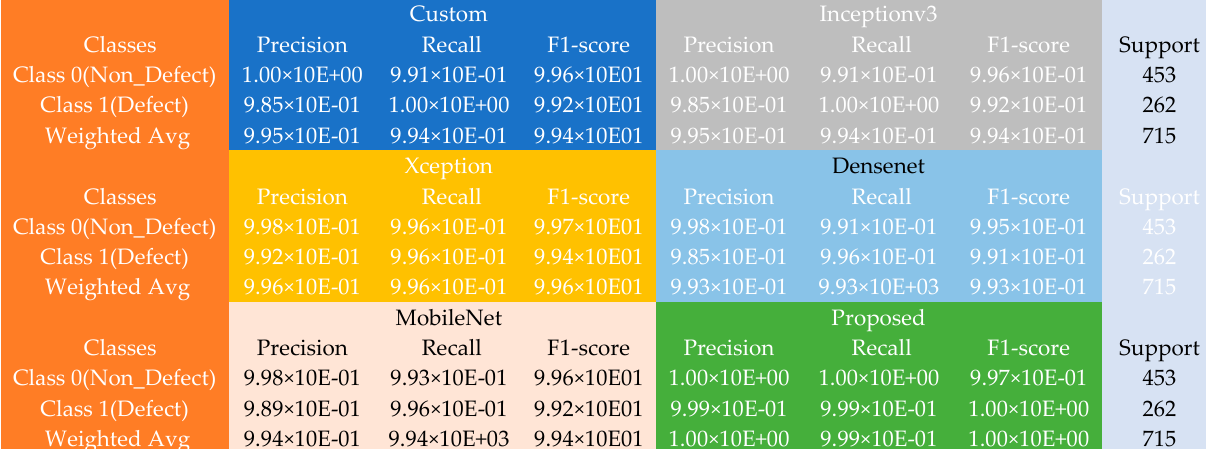
and MSLE of 5.34 × 10 − 3 . Table 5. The classification report for each of the models and the final model using the PCB dataset.